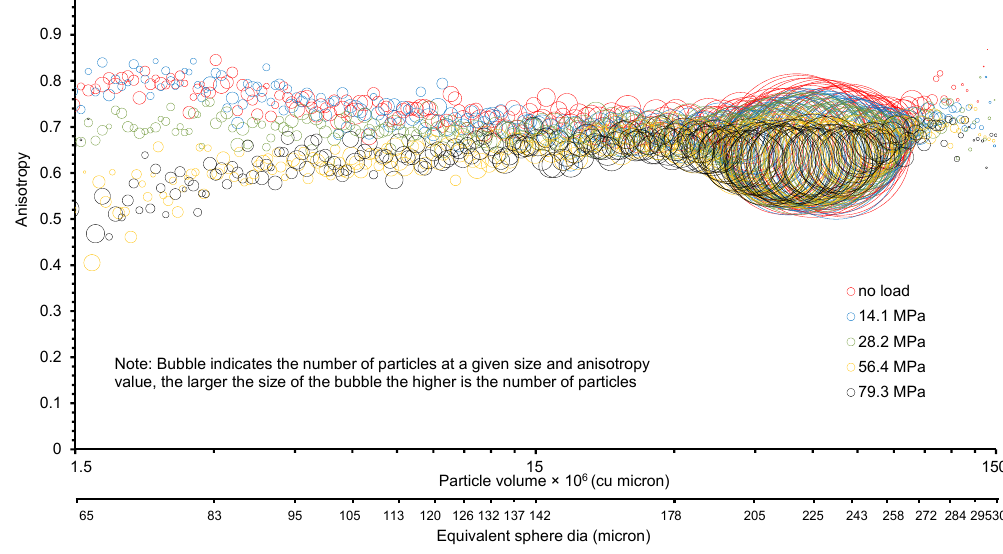
Figure 16. Particle anisotropy and frequency distributions with vertical stresses.